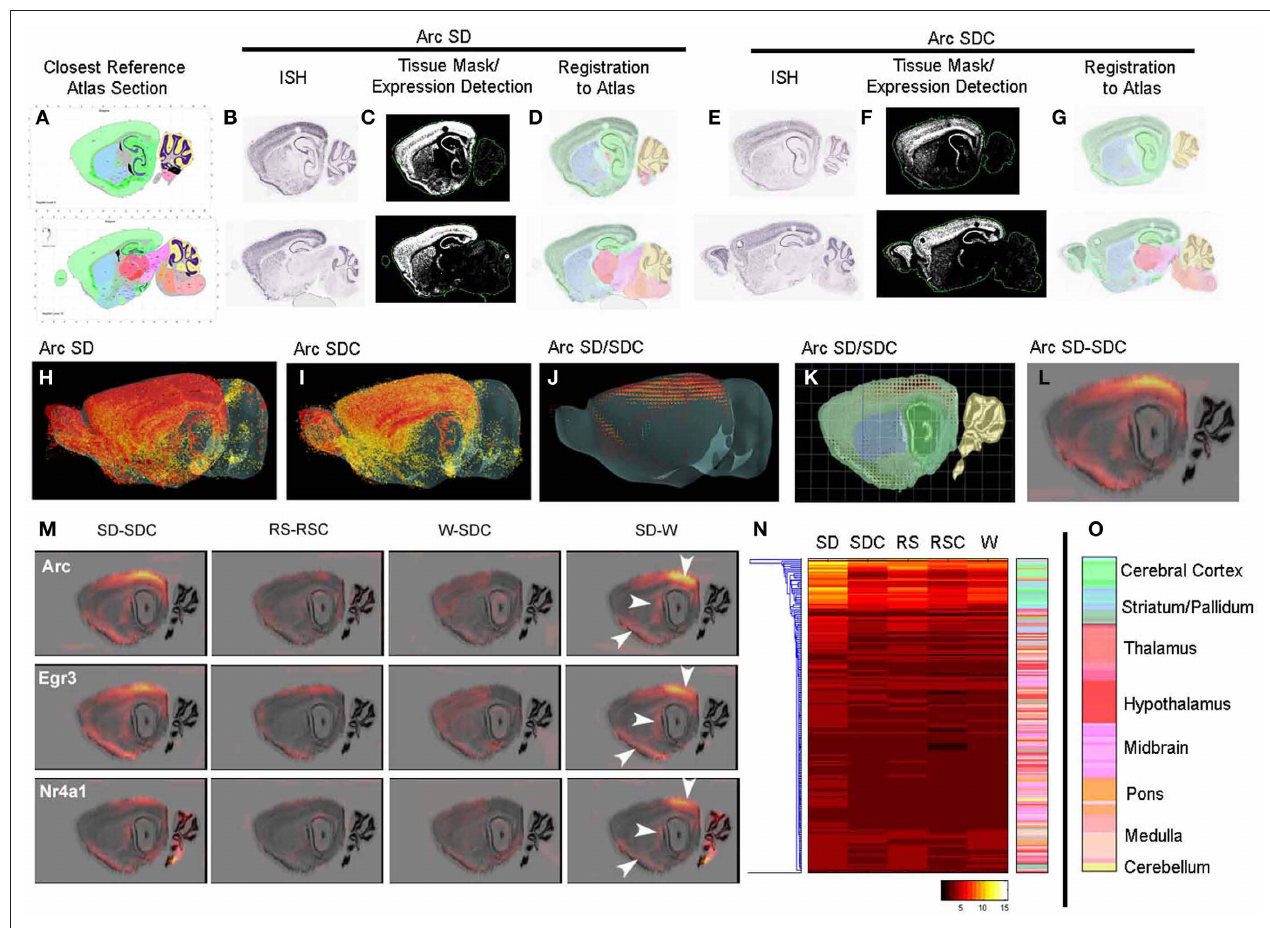
patterns by SD for these IEGs in specific anatomical structures including the neocortex, caudate putamen and piriform cortex visible at this resolution (arrows). SD leads to dramatic quantitative changes relative to SDC (left panel) and waking (right panel), while less robust differences are seen between W and SDC and between RS and RSC (middle panels). (N) Hierarchical clustering of Arc quantification across 209 brain regions over five behavioral conditions. Individual rows represent specific anatomical regions, color-coded by their position in the hierarchical structural ontology of the Allen Reference Atlas (right panel). The heatmap is colored by relative expression, based upon the metric expression energy (see Materials and Methods), with white/yellow representing high expression and black representing low expression, as denoted in the color key at the bottom. (O) Color key for anatomical regions as shown in (N)